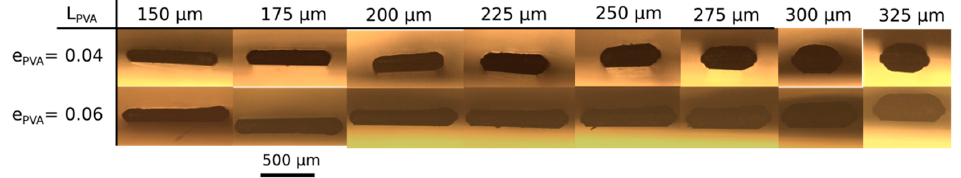
Figure 6. Cross-sectional optical microscopy of PVA layers, e PVA = 0.04 and e PVA = 0.06, for layer separations L PVA = 150 to 325 µm.